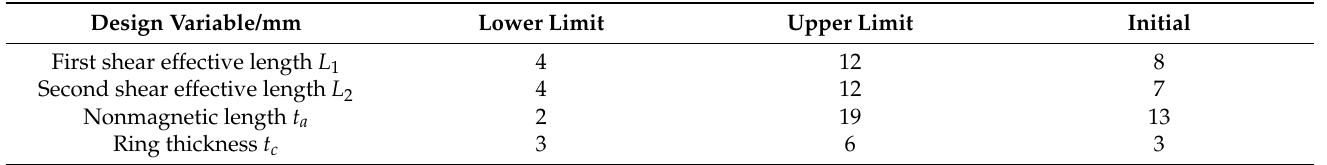
Table 2. Upper and lower limits of design variables of the damper structure